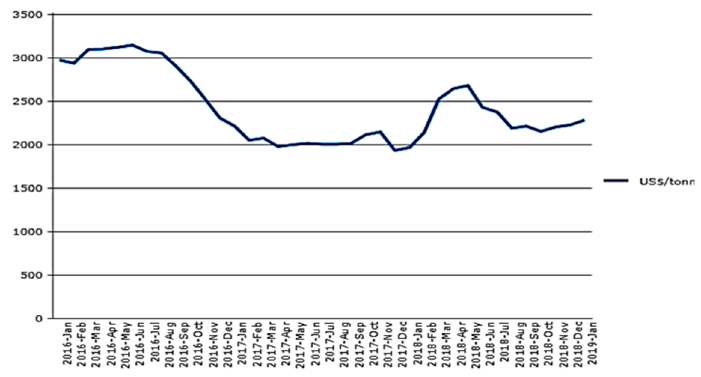
Figure 3. Monthly averages of daily prices. Source: [61].